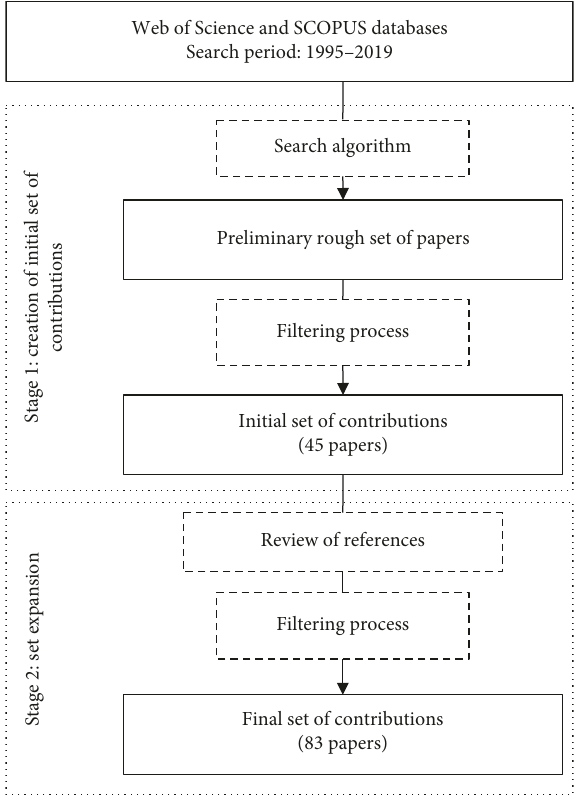
Figure 1: Systematic literature